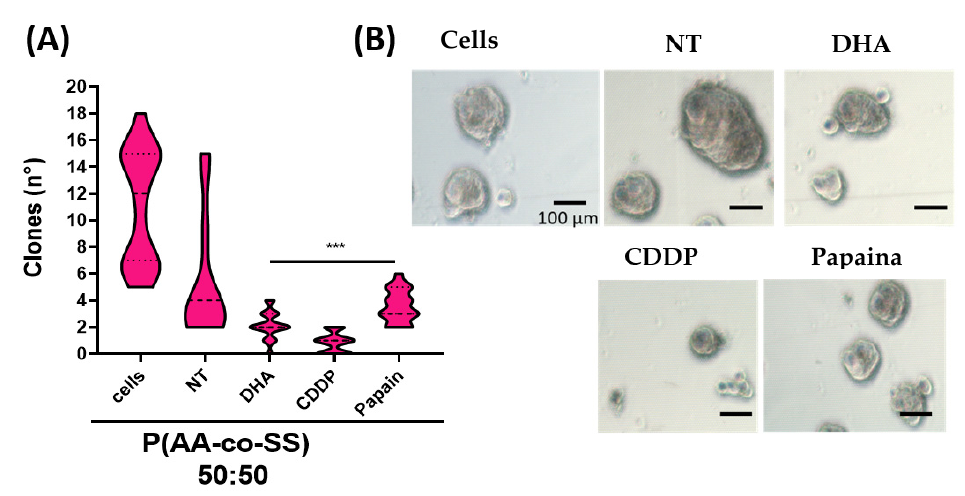
Figure 10. Growth independent anchored assays of MDA-Mb-231 breast cancer cells in the presence of EpnF mesh charged with chemotherapeutic/adjuvant drugs. ( A ) The breast cancer cells MDA-MB-231 were cultured in the absence of cells and with P(AA- co -SS) (50:50) loaded with 50 µM of DHA, 100 µM of CDDP, and 1.5 µg/mL Pap in semi-solid agar. The graph showed the total number of clones formed and representative optical images from clonogenic assays under each condition. The amplification bar represents 100 µm ( n = 3, *** p ˂ 0.001). ( B ) OM images from clone growing assays with P(AA- co -SS) (50:50) mesh. The amplification bar is 100 µm in the MDA-Mb-231 gastric cancer using P(AA- co -SS) (50:50) and charged with 50 µM of DHA, 100 µM of CDDP, and 1.5 µg/mL of Pap.